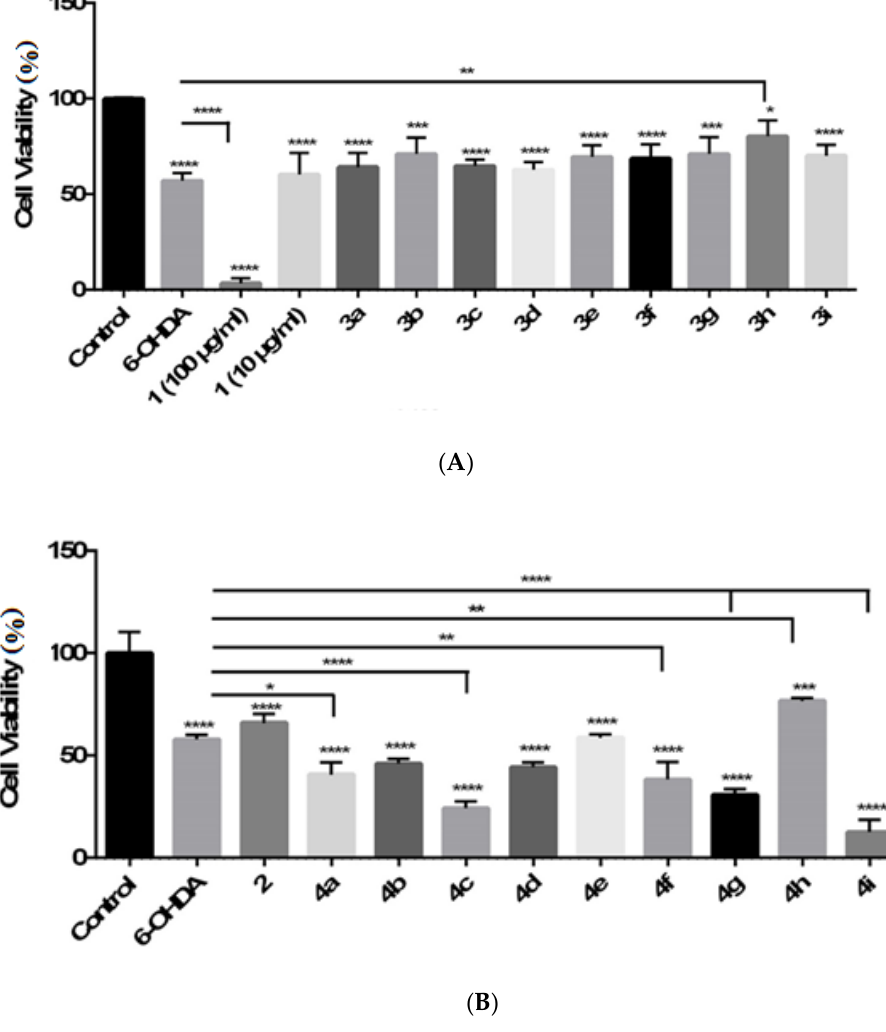
Figure 2. Neuroprotective effects of compounds 1 and 3a – i ( A ); 2 and 4a – i ( B ) against 6-OHDA induced neurotoxicity. PC-12 Adh cells were treated with 100 µg/mL concentration of the compounds for 6 h before exposure to 150 µM 6-OHDA for 24 h. The cell viability was detected at the 24th hour. The results of the cell viability were presented as a % of the control (the O.D. value). Data are shown as mean ± SD of three experiments. (( n = 8), p > 0.05 n.s., * p < 0.05, ** p < 0.01, *** p < 0.001, and **** p < 0.0001).